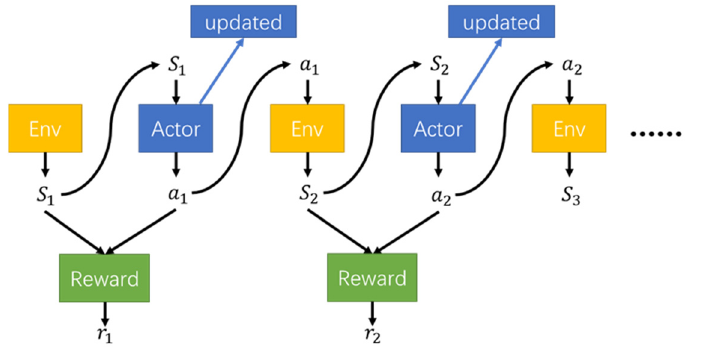
Figure 4. Trajectory of interaction between actor π and environment.